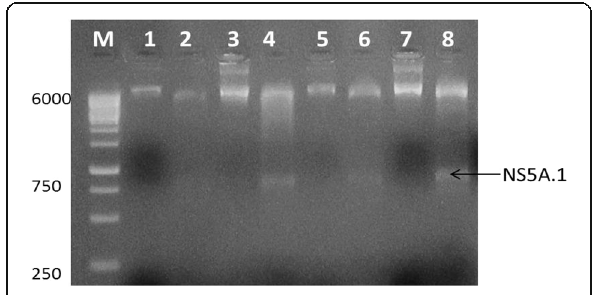
Fig. 6 Restriction and digestion analysis of pet vector expressing NS5A.1 antigenic site. Lanes 1, 3, 5, and 7: uncut plasmids; lanes 4, 6, and 8: positively digested plasmids; M: 1 kb marker